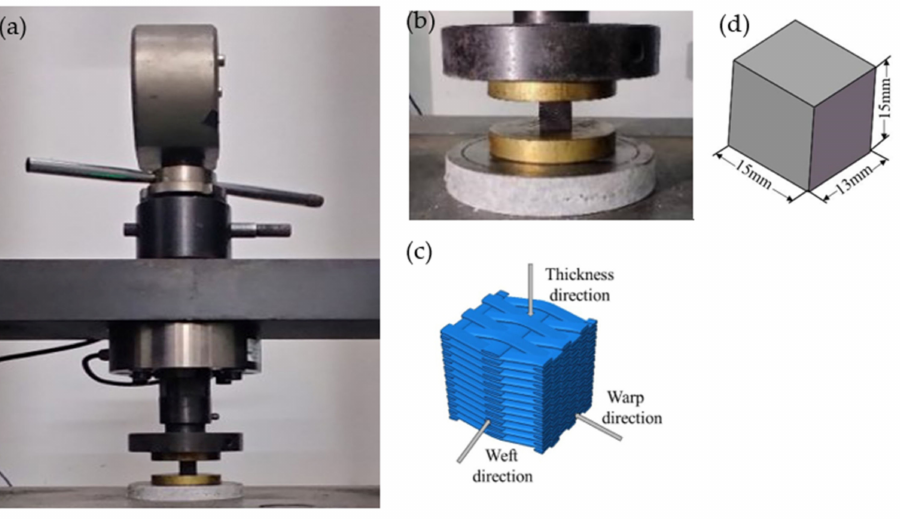
Figure 2. Compression test diagrams: ( a ) specimen under compression load; ( b ) experimental specimen closer view; ( c ) loading diagram; ( d ) specimen